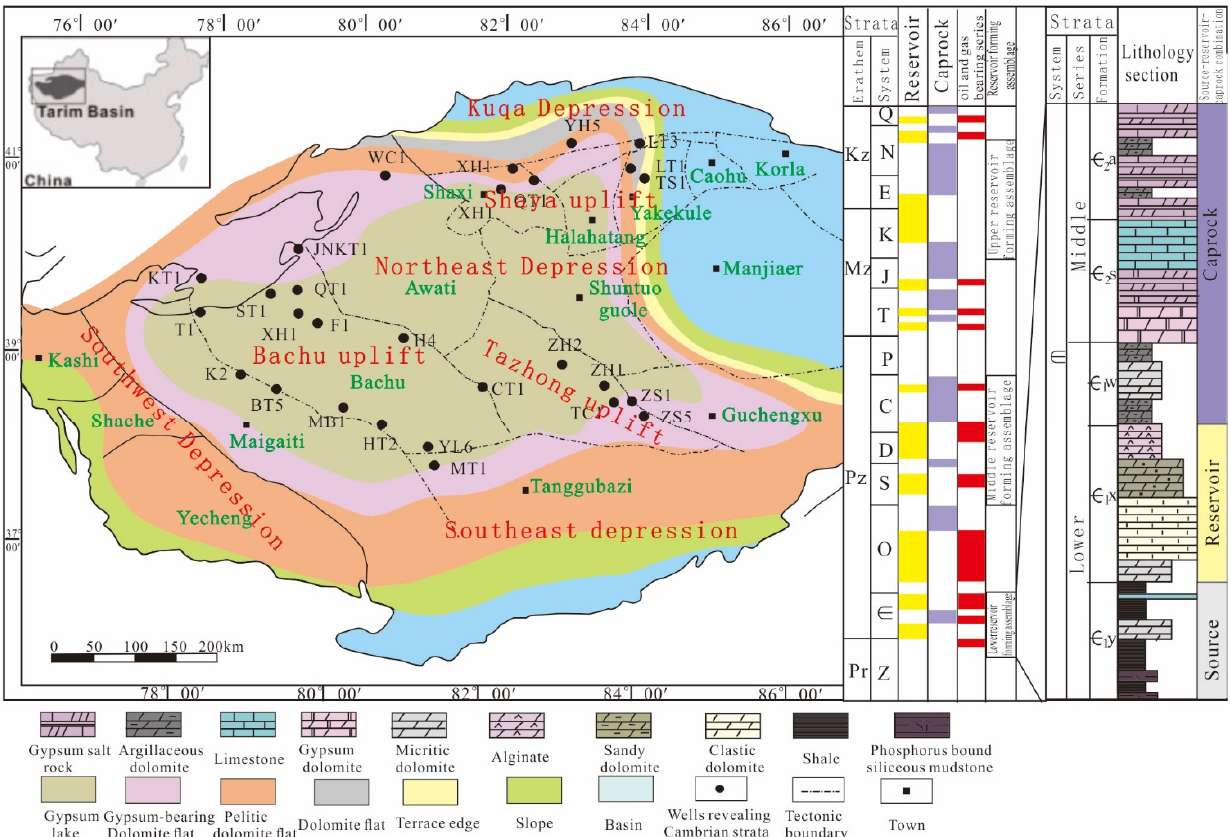
Figure 1. Sedimentary phases, tectonic features, and tectonic profiles of the Middle–Lower Cambrian in the Tarim Basin (modified after Jia et al., 2021 [21]). Є 1 y = Yuertusi Formation, Є 1 x = Xiaoerbulake Formation, Є 1 w = Wusonger Formation, Є 2 s = Shayilike Formation, Є 2 a = Awatag Formation.